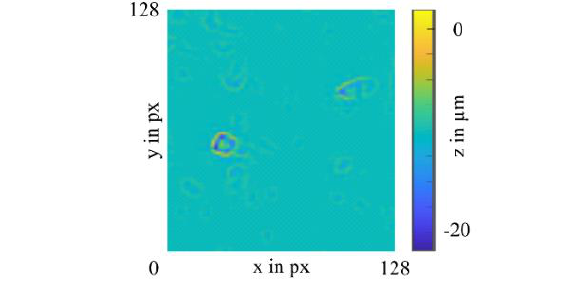
Fig. 3. Example for a residual image generated by the VDSR Net for a 4x